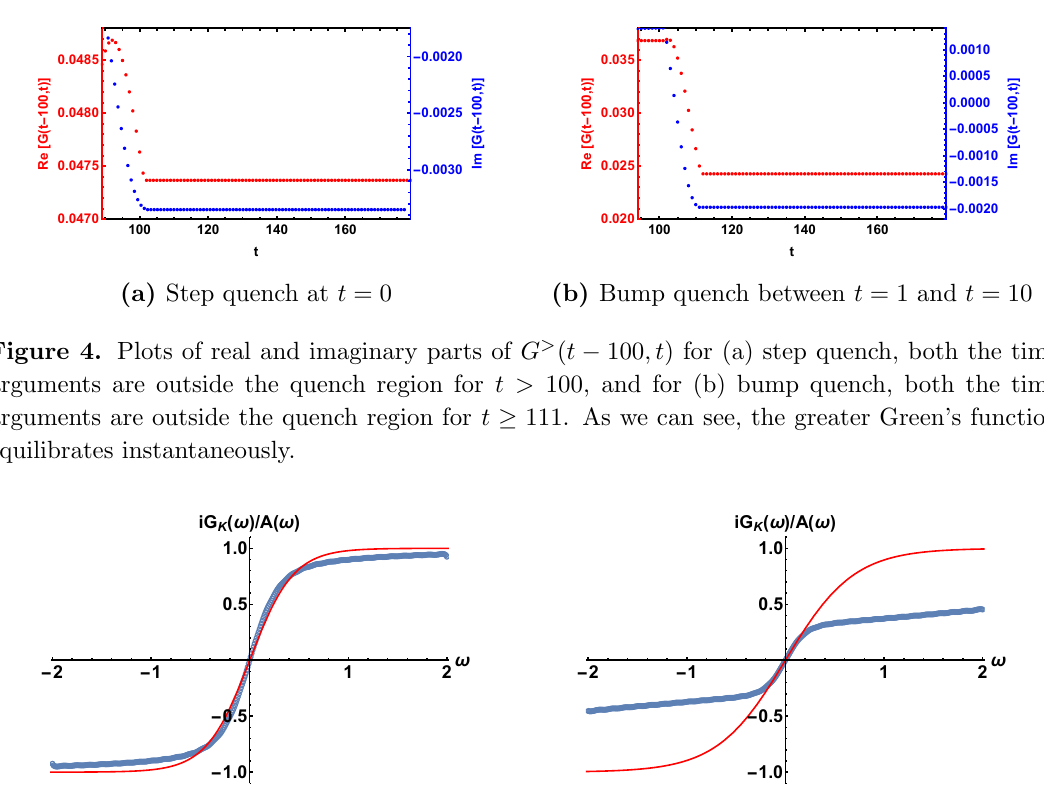
For the bump quenches, starting from a theory with only J duration of 9 (cid:2) dt = 9 (cid:2) 0 : 05 = 0 : 45 from time step t = 1 to t = 10. As mentioned